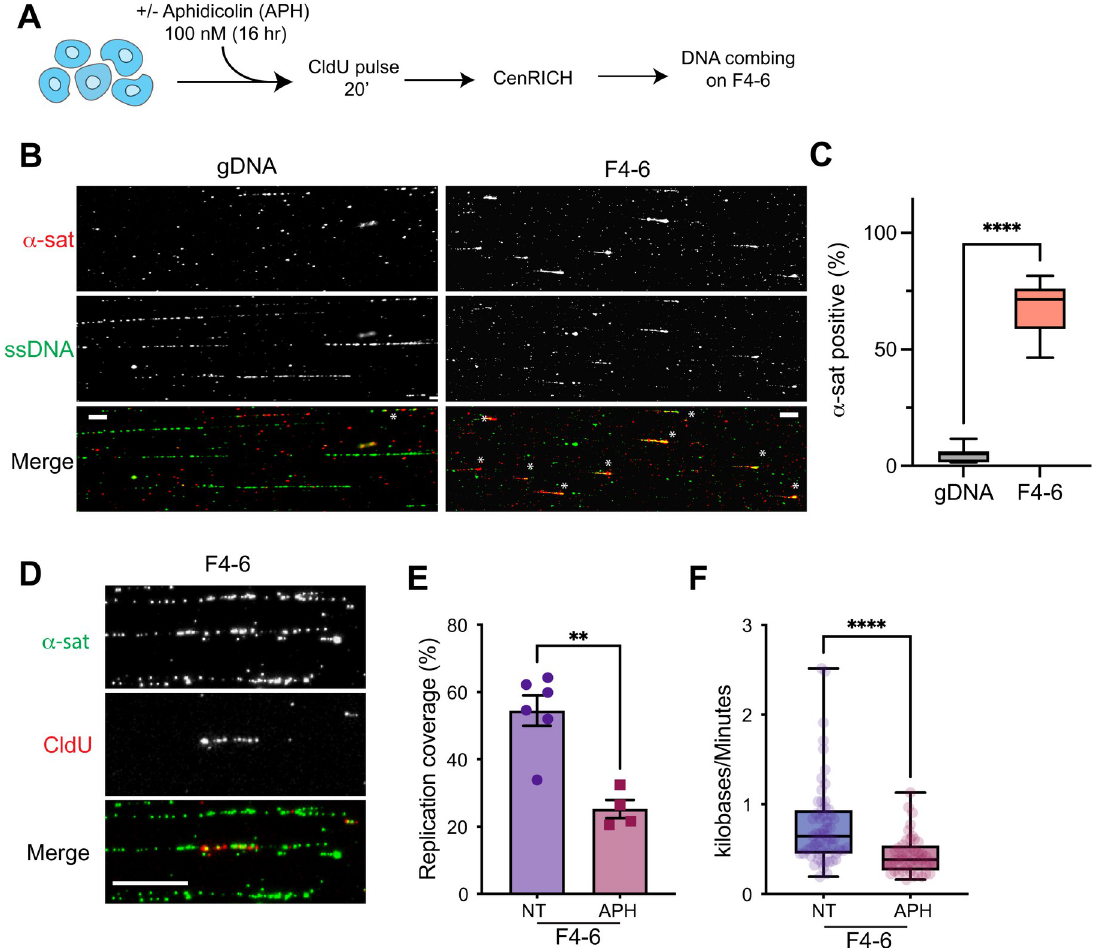
Fig 5. CenRICH is suitable for single molecule replication analysis. A. Schematic representation of the experimental design. B. Representative images of DNA fibers hybridized with an anti single-stranded DNA (ssDNA) antibody and biotin labelled α -satellite probe in the indicated condition. Asterisks mark α -satellite positive fibers. Scale bar 20 μ m (gDNA) and 10 μ m (F4-6). C. Box and whiskers plot shows the percentage of DNA fibers that are positive to hybridization with α -satellite probe, in a non-enriched sample of RPE-1 DNA (gDNA) or in the HMW fraction after CenRICH on RPE-1 cells with the SNE enzyme combination. Fibers of less than 10 kb were excluded from the analysis. n = > 350 fibers for F4-6 and > 230 for gDNA. Mann Whitney test, p < 0.0001. D. Representative images of CldU incorporation on combed DNA fibers, as marker of ongoing replication in RPE-1 cells that underwent CenRICH with the SNE enzyme combination. Scale bar 10 μ m. E. Mean cumulative percentage of DNA fibers showing CldU incorporation in an untreated sample (NT) or in a sample treated with aphidicolin (APH). Both samples derive from RPE-1 cells after CenRICH with SNE enzyme combination. Each dot represents one image with an average of ~8 fibers. Error bars represent SEM. Mann Whitney test, p = 0.0095. F . Box and whiskers plot showing fork velocity (expressed as Kb/minute) as measured from the CldU incorporation rate. Same samples as E. Whiskers range from minimum to maximum values. Box is showing the 25, 50 and 75% percentile. n = 59 and 44 for NT and APH respectively. Mann Whitney test, p <